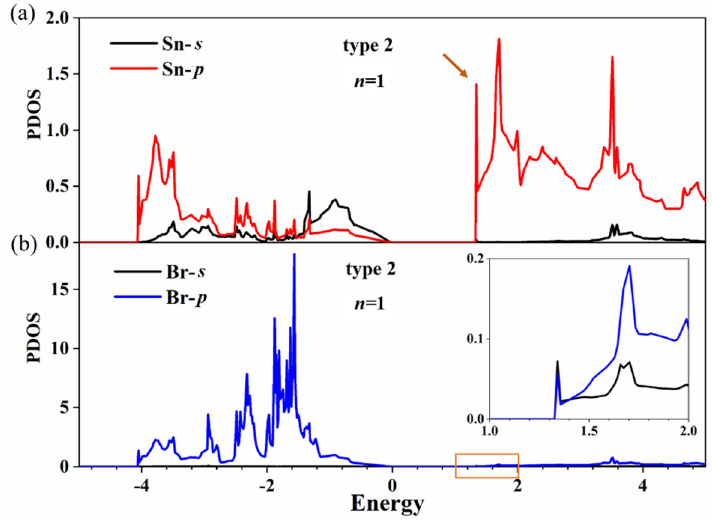
Figure 6. PDOS of Sn ( a ) and Br ( b ) atoms in the SnBr 2 -terminated surface for Cs n Sn n +1 Br 3 n +2 ( n = 1). The inset of ( b ) is an enlargement of the orange box.